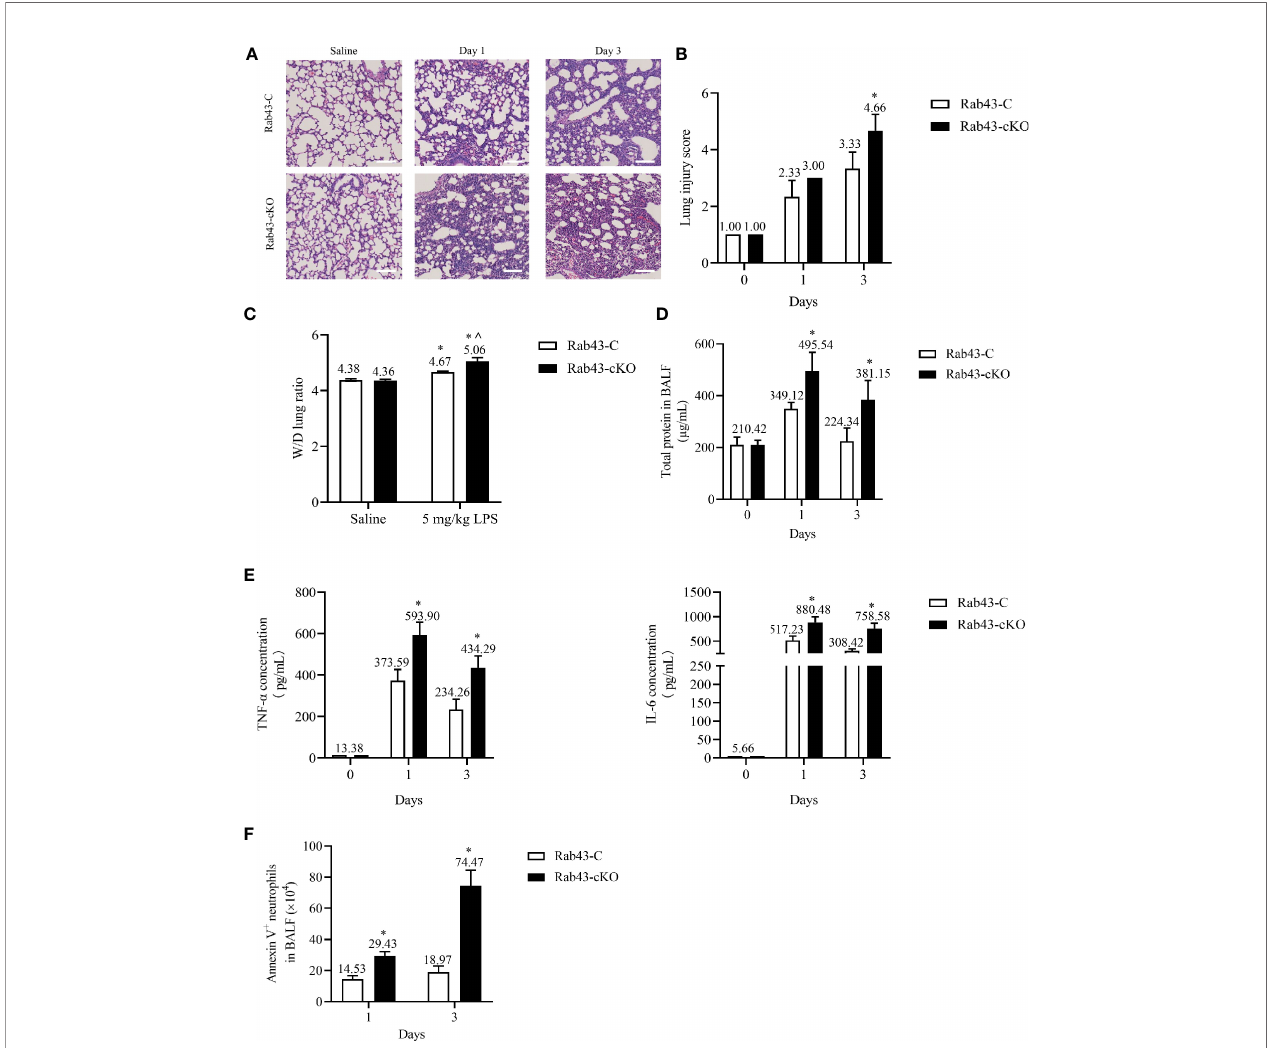
FIGURE 8 | Rab43 knockout delays in fl ammation resolution and exacerbates lipopolysaccharide (LPS)-induced acute lung injury (ALI) in mice. The Rab43-C and Rab43-cKO mice were treated with 5 mg/kg LPS (i.t.) at the indicated time points. (A) Hematoxylin and eosin (H&E) staining images showing the lung tissue injury. (B) The lung injury scores in the Rab43-C and Rab43-cKO groups. * P < 0.05 versus the Rab43-C group at indicated time points. (C) The level of lung edema was determined by measuring the wet-to-dry lung weight ratio. * P < 0.05 versus the Rab43-C saline group, ^ P < 0.05, vs Rab43-C/5 mg/kg LPS group at indicated time points. (D) The protein concentrations in the bronchoalveolar lavage fl uid (BALF) samples were analyzed using the bicinchoninic acid method. * P < 0.05 versus the Rab43-C group. (E) The levels of TNF- a (left panel) and IL-6 (right panel) in the BALF samples detected by enzyme-linked immunosorbent assay. * P < 0.05 versus the Rab43-C group at indicated time points. (F) Annexin V+/Ly6G+ cells were counted as apoptotic neutrophils using fl ow cytometry. * P < 0.05 versus the Rab43-C group at indicated time